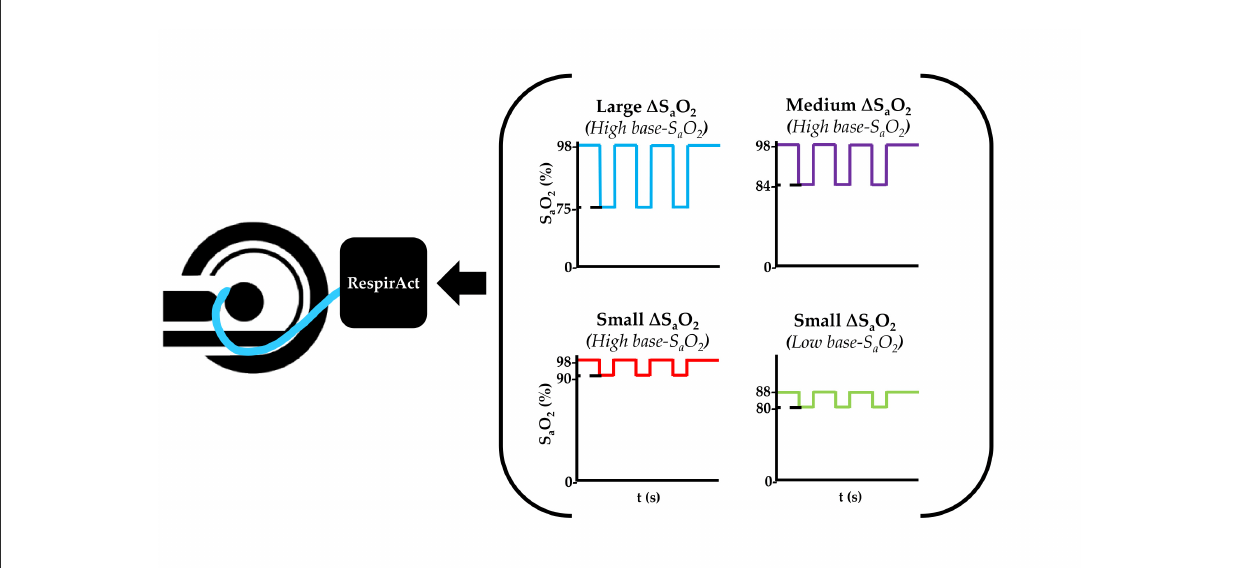
FIGURE1 Summary of the dOHb Experimental Method. Subjects ( n = 6) were imaged in a 3T MRI scanner with a mask attached to the RespirAct ® , where S a O 2 was altered to attain desired levels of base-S a O 2 and 1 S a O 2 . In sum, the following paradigms were generated: small 1 S a O 2 with high base-S a O 2 (red: 98–90% S a O 2 ), medium 1 S a O 2 with high base-S a O 2 (purple: 98–84% S a O 2 ), large 1 S a O 2 with high base-S a O 2 (blue: 98–75% S a O 2 ), and small 1 S a O 2 with low base-S a O 2 (green: 88–80% S a O 2